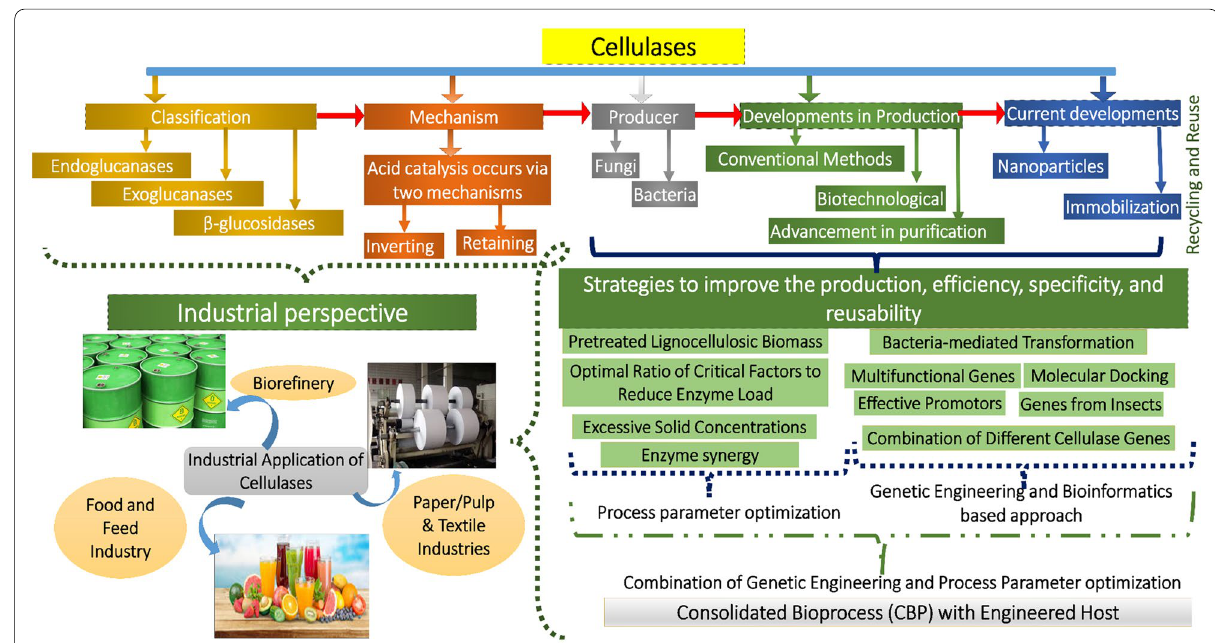
Fig. 1 Schematic representation of the various important aspects of microbial